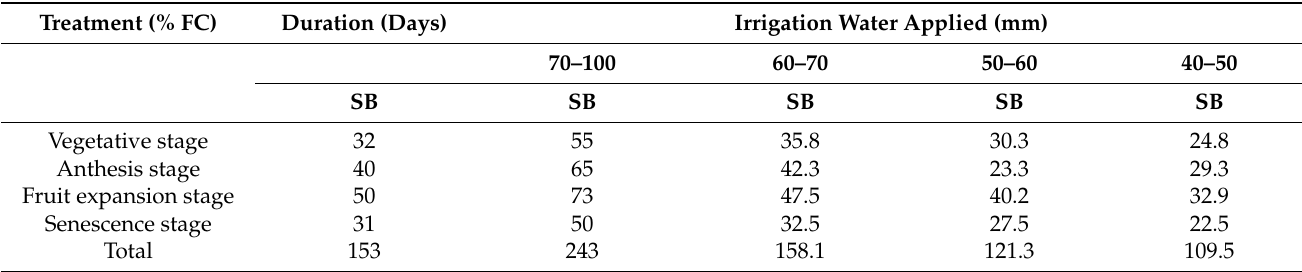
Table 6. Irrigation water applied for tomatoes throughout the growing cycle for each growth stage for the different treatments in silty loam soil (SB).